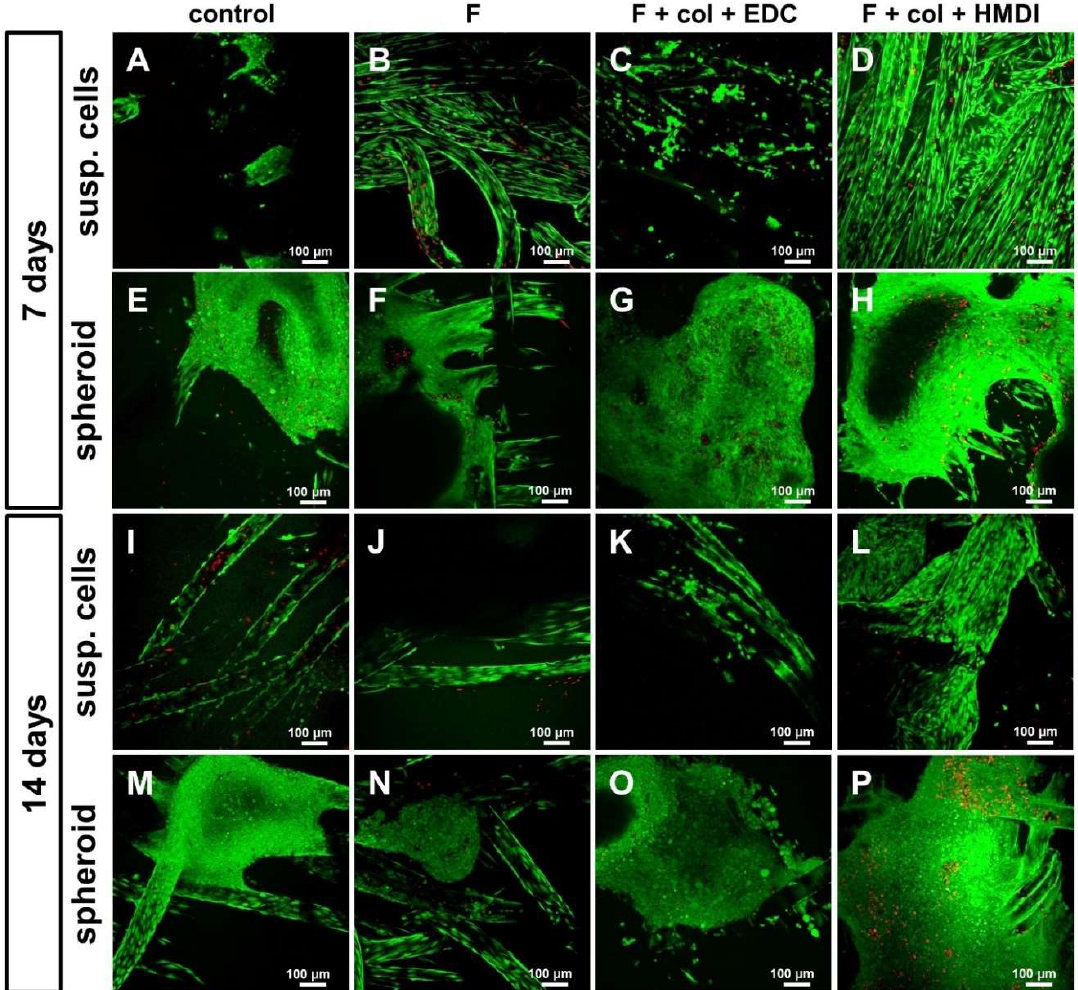
Figure 3. Vitality assay of functionalized scaffold variants cultured either dynamically seeded with suspended cells (susp. cells, A – D , I – L ) or statically with spheroids ( E – H , M – P ). Control ( A , E , I , M ), fluorinated ( B , F , J , N ), fluorinated + collagen + EDC ( C , G , K , O ) and fluorinated + collagen + HMDI ( D , H , L , P ) after 7 ( A – H ) and 14 days ( I – P ) in culture. Representative pictures of three independent experiments using cells from three different donors show living cells: green and dead cells: red. Scale bars of 100 µm. Col, collagen foam; F, fluorinated; EDC, ethylcarbodiimide cross-linked; HMDI, hexamethylene diisocyanate cross-linked.